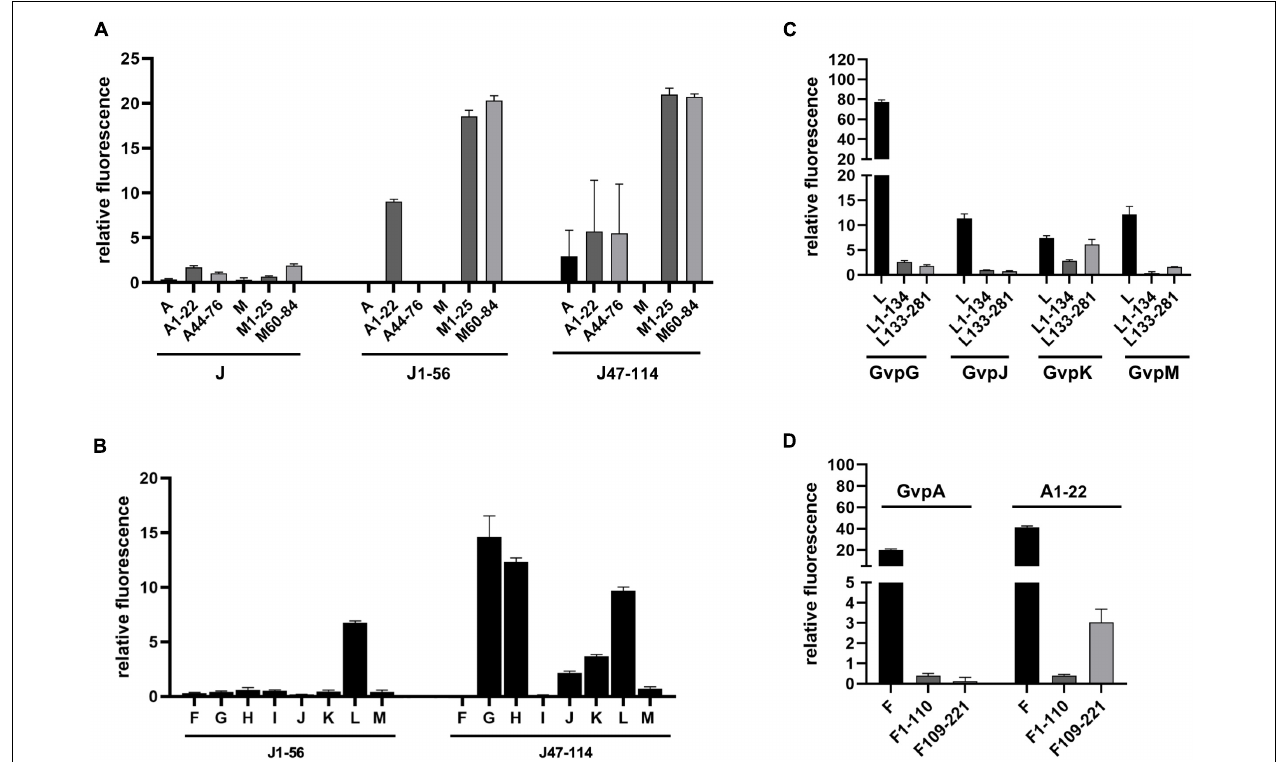
FIGURE 7 | Split-GFP analyses of Gvp proteins. (A) Rf values of the interaction studies of GvpJ, J1–56, or J47–114 with the entire GvpA and GvpM, or with N- and C-terminal fragments. The fragments indicated at the bottom are A1–22 and A44–76 in the case of GvpA, M1–25, and M60–84 in the case of GvpM, and J1–56 and J47–114 in the case of GvpJ. (B) Rf values of the interaction study of J1–56 and J47–114 with the accessory proteins GvpF through GvpM. (C) Rf values of the interaction study of L1–134 or L133–281 with GvpG, GvpJ, GvpK, and GvpM. (D) Rf values of the interaction study of F1–110 and F109–221 with GvpA and A1–22.